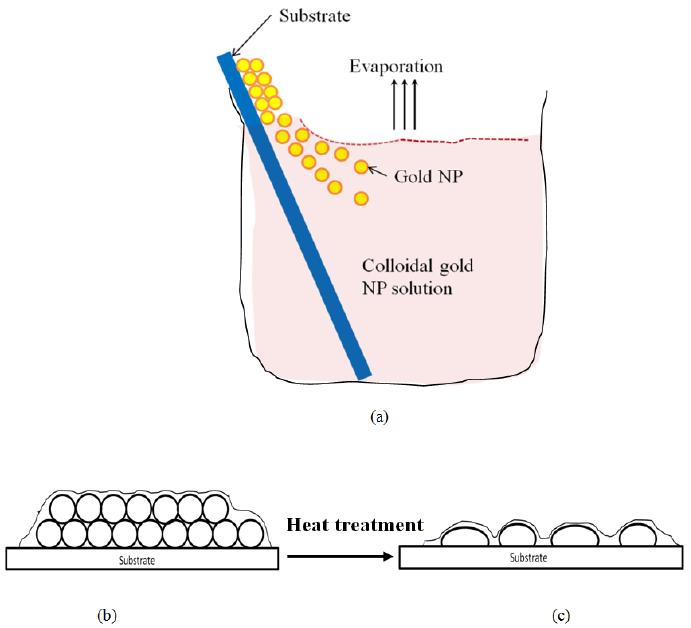
Figure 8. Fabrication strategy of the gold nano-island structure on a substrate. ( a ) angled convective assembly [21] ( b ) schematic of gold aggregates and ( c ) schematic of gold nano-islands